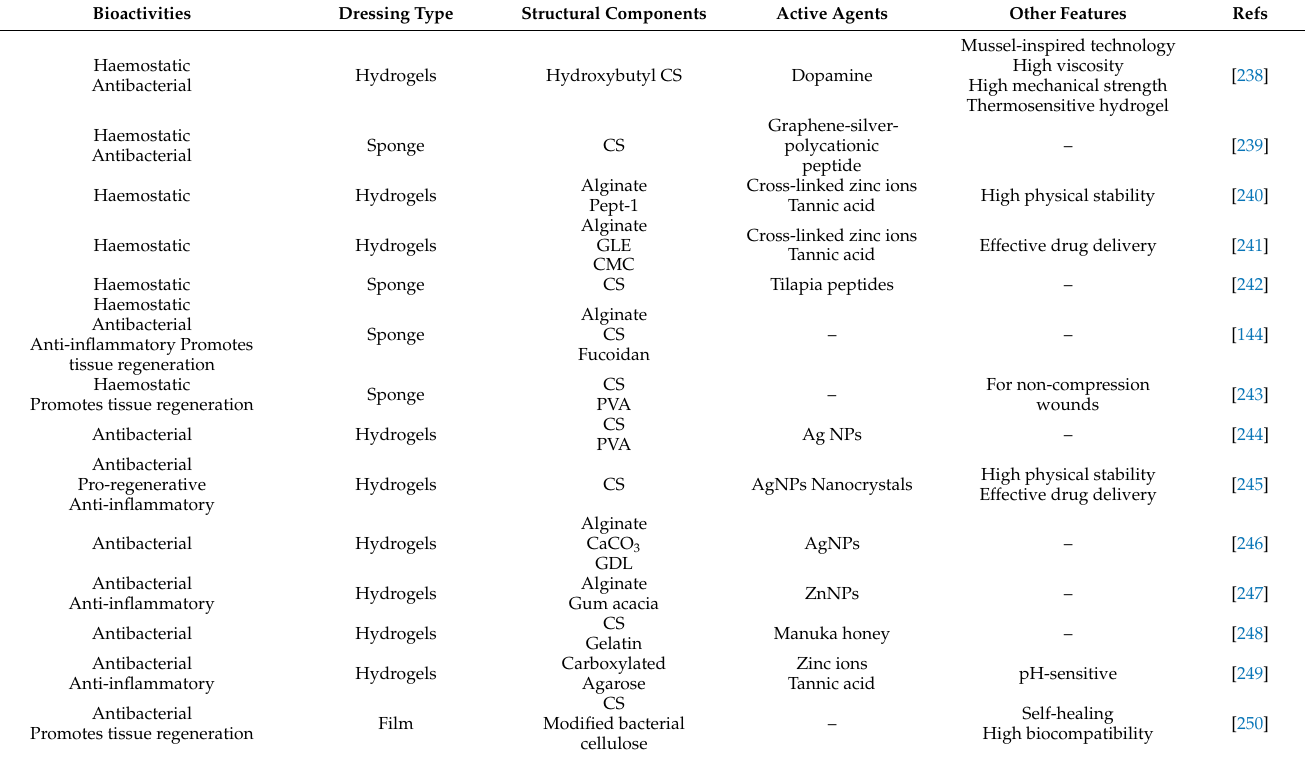
Table 6. Summary of the raw materials and characteristics of MPs activities-enhanced wound dressings in recent years.